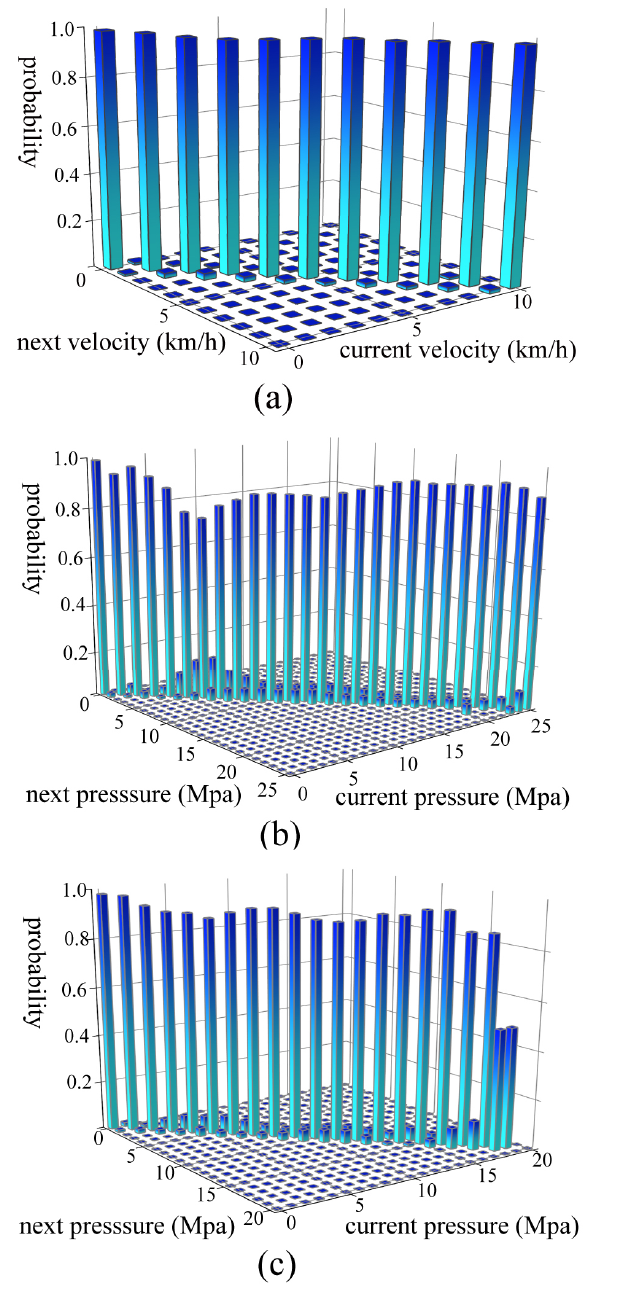
Figure 6. Transition probability for small coarse gravel. ( a ) Velocity of wheel loader. ( b ) Lift cylinder pressure. ( c ) Tilt cylinder